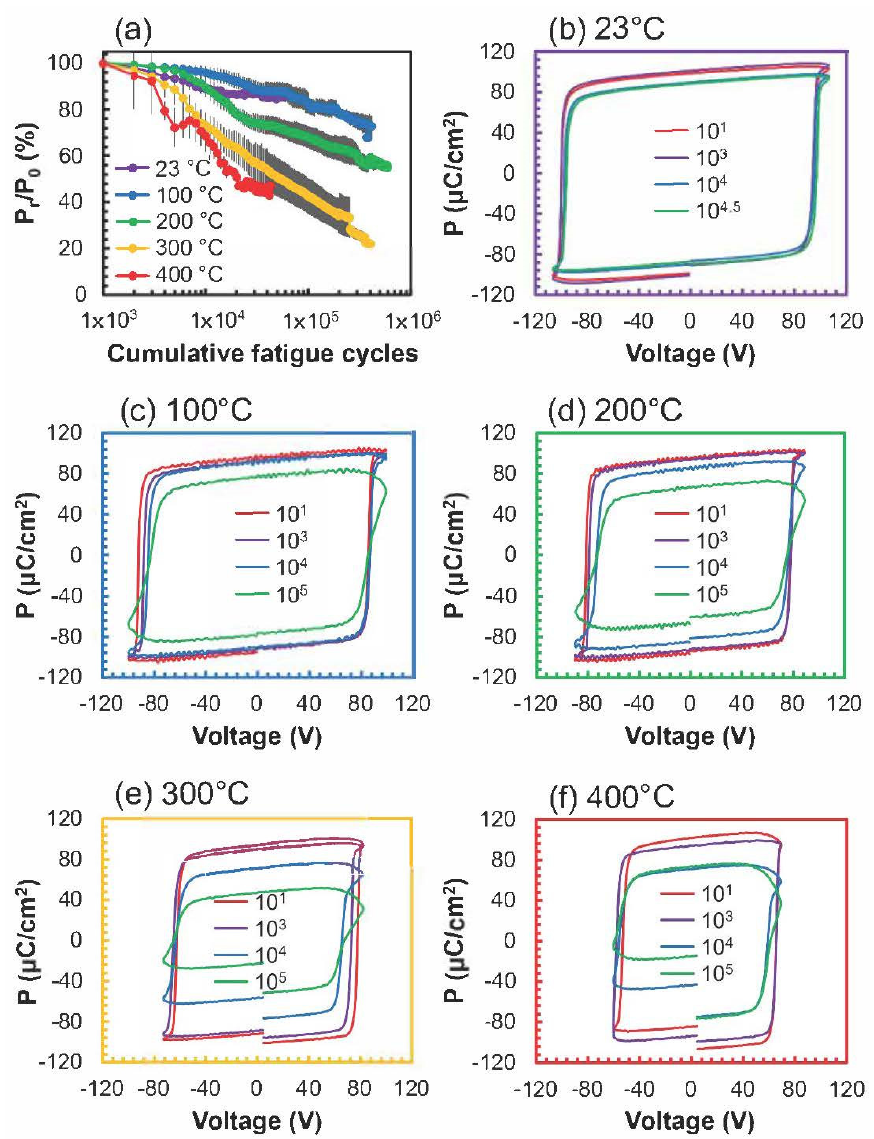
Figure 5. Ferroelectric fatigue exhibits a strong dependence on the measurement temperature. ( a ) Normalized P r dependence on cycles for temperatures between 23 and 400 °C with error bars of a standard deviation. Representative P–E loops throughout the fatigue cycling for ( b ) 23 °C, ( c ) 100 °C, ( d ) 200 °C, ( e ) 300 °C, and ( f ) 400 °C. The colors of the plot borders for ( b – f ) correspond to the temperature of the measurement in ( a ), and the different traces in ( b – f ) are consistent for ease of comparison.